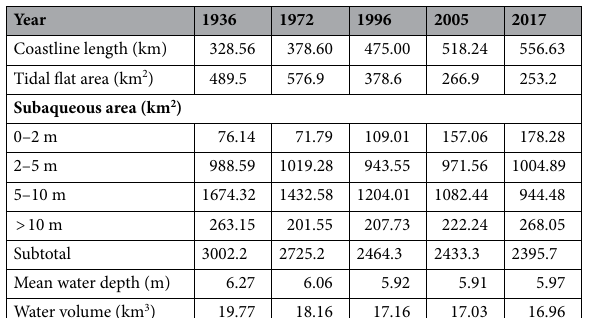
Table 1. Coastline length, tidal flat area, subaqueous area and water volume in the Pearl River Estuary, 1936–2017.